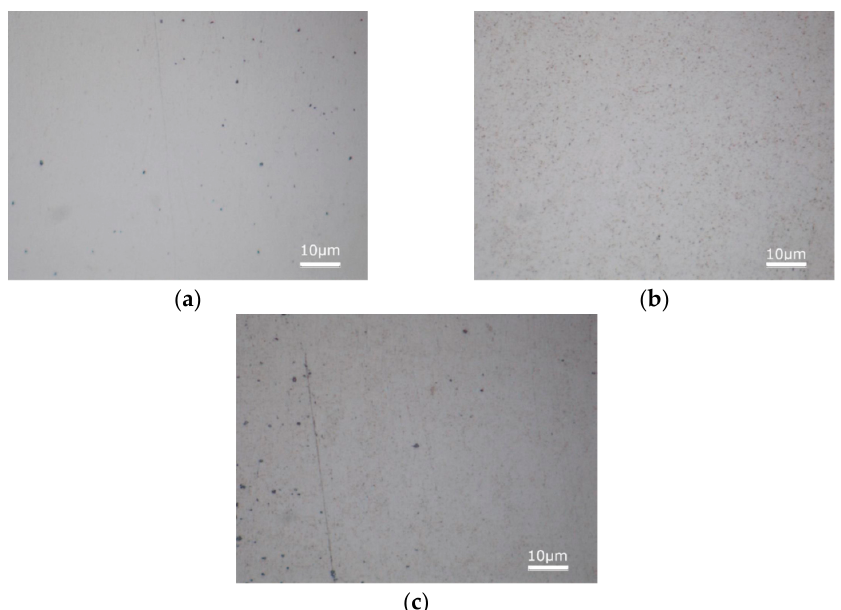
Figure 3. Optical microscopy images of samples ( a ) #6; ( b ) #8, and ( c ) #10 after palladium displacement deposition.